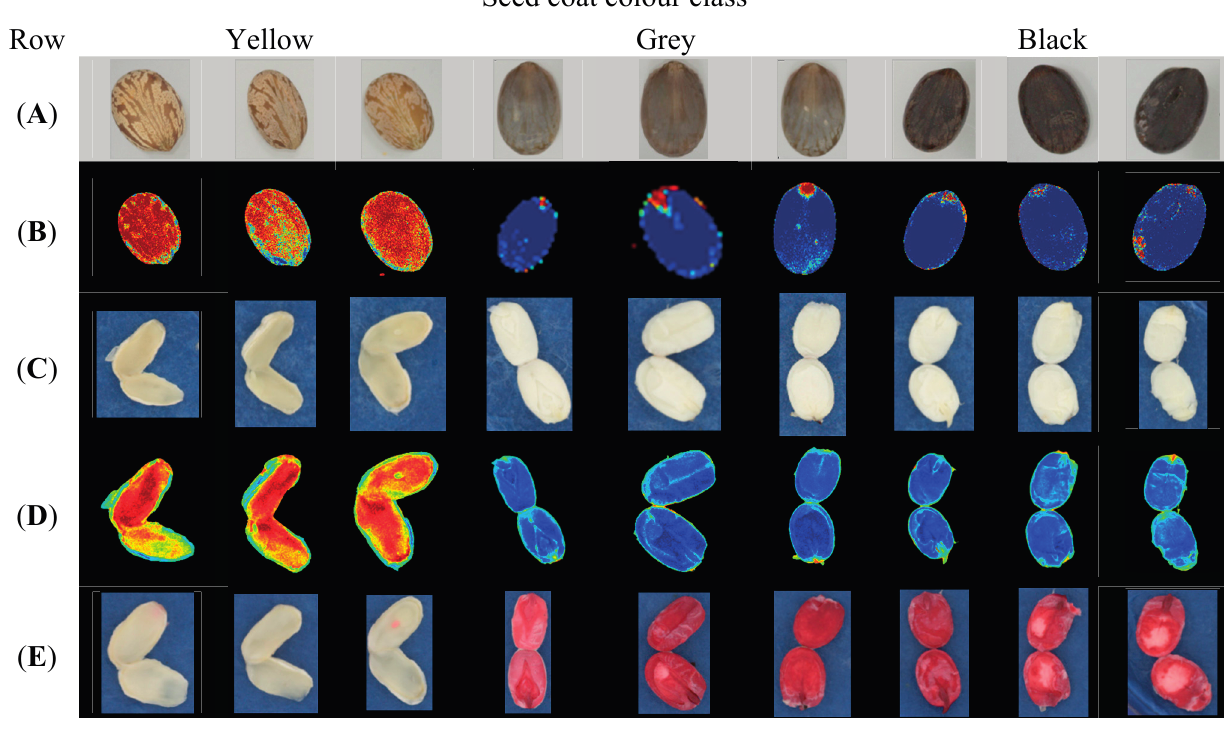
Figure 2. Overview of seeds divided into three classes based on visual colour of seed coat: yellow, grey and black. Row ( A ) shows RGB images of the intact seeds; ( B ) is images transformed by nCDA to divide dead and viable seeds (intact seeds); ( C ) is RGB images of cut seeds; ( D ) is images transformed by nCDA to divide dead and viable seeds (based on cut seeds) and ( E ) is RGB images taken after the cut seeds has been immersed in tetrazolium.